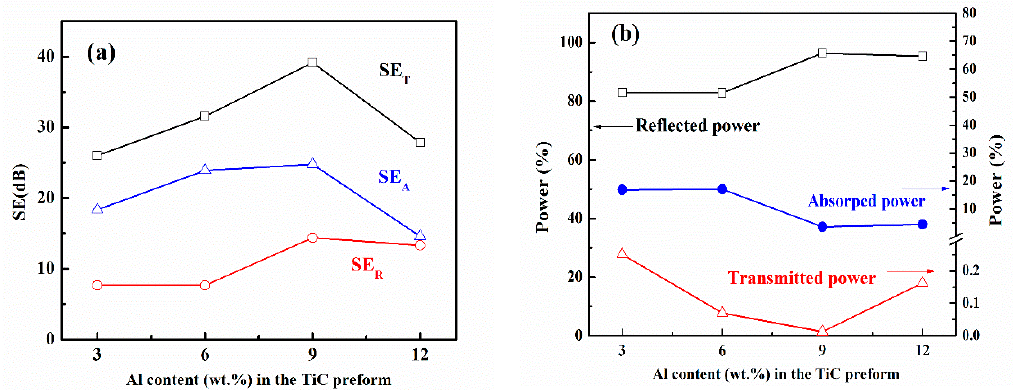
Figure 6. ( a ) SE T , SE R , and SE A of all four samples with thickness of 3 mm, and ( b ) power balance as a function of Al content.